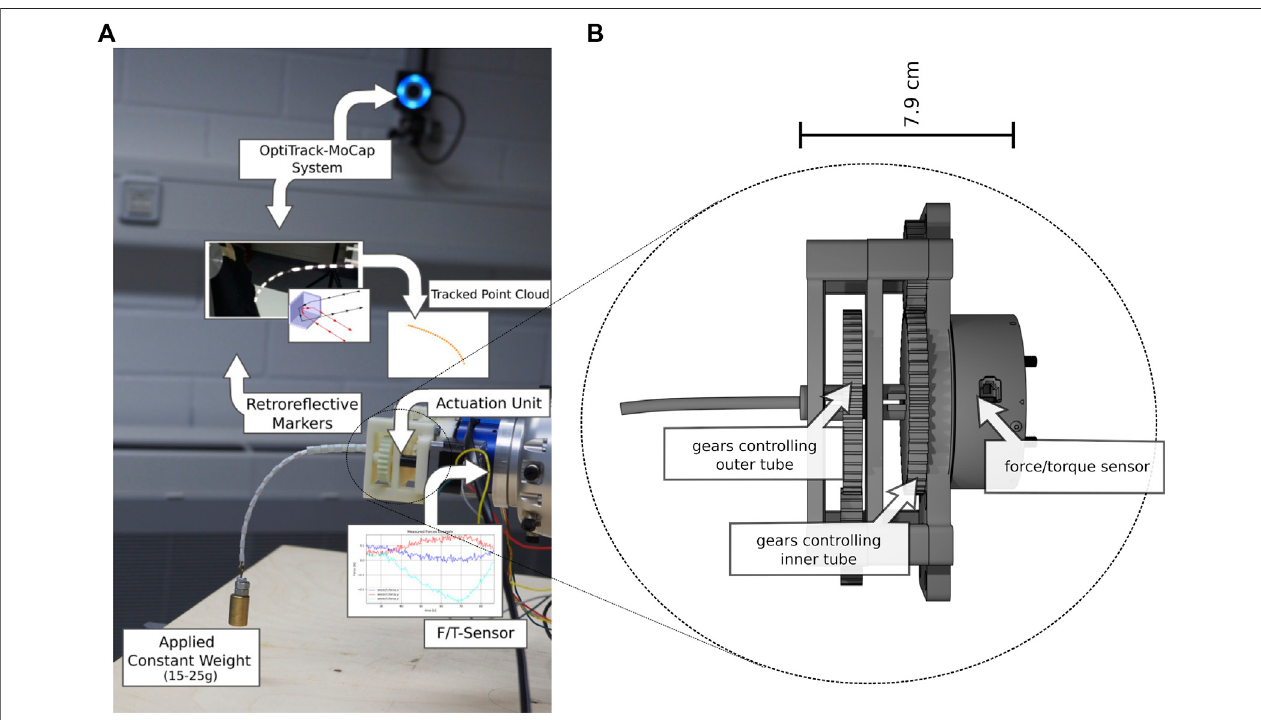
FIGURE5| Overviewoftherecordingwithlabelsforthehardwarepartsandvisualizationoftheirrecordings. (A) Experimentalsetup (B) Schematicofcustommade actuation unit with F/T-sensor. Further, a) shows the combination of an inner tube of 150 mm with and outer tube of 50 mm and a weight of 25 g, which yielded large de fl ections of the tubes.